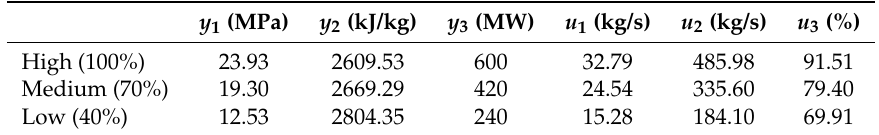
Table 1. Typical steady-state operation conditions of the supercritical circulating fluidized bed (CFB)